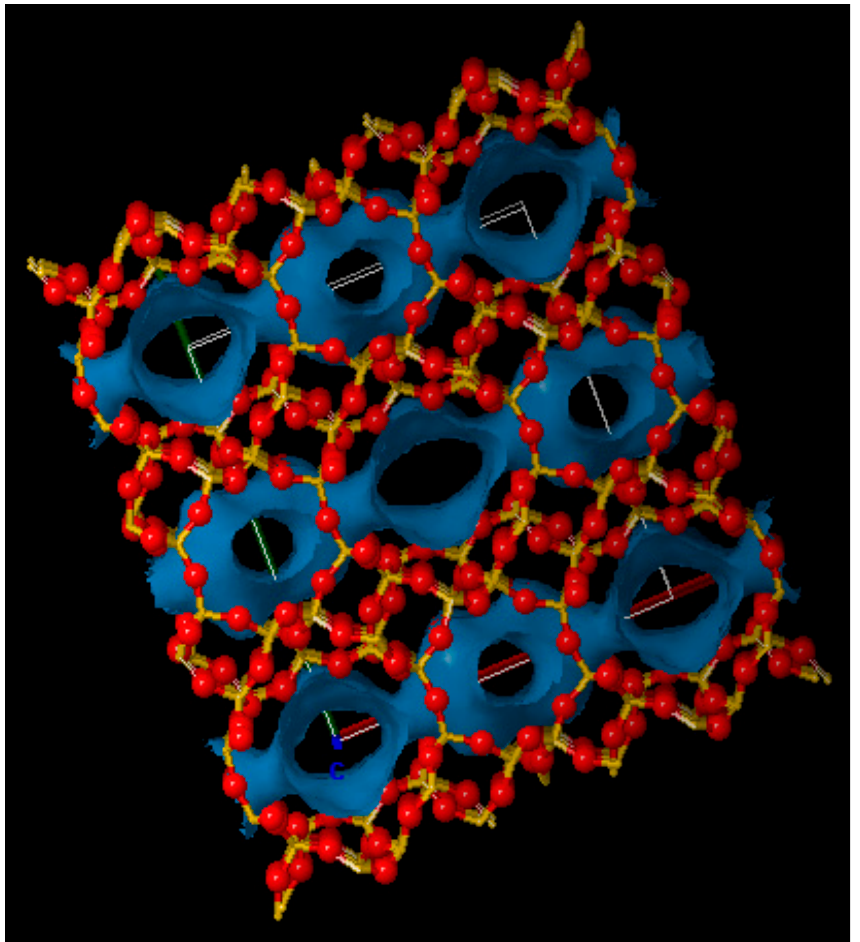
Figure 1. A three ‐ dimensional simulation that schematically shows Si and O ions (yellow and red Figure 1. A three-dimensional simulation that schematically shows Si and O ions (yellow and red balls, respectively) and the internal surface of channels (light ‐ blue surface). [5]. balls, respectively) and the internal surface of channels (light-blue surface)